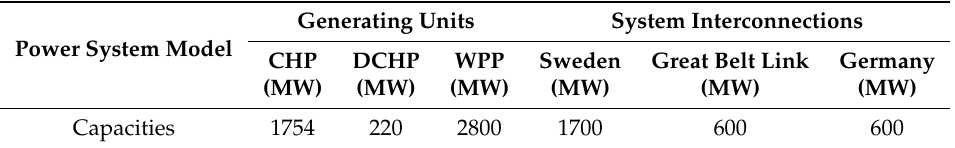
Table 1. Capacities of generating units and system